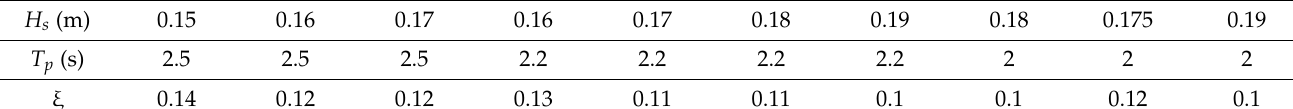
Table 2. Input wave parameters for breaking wave generation.